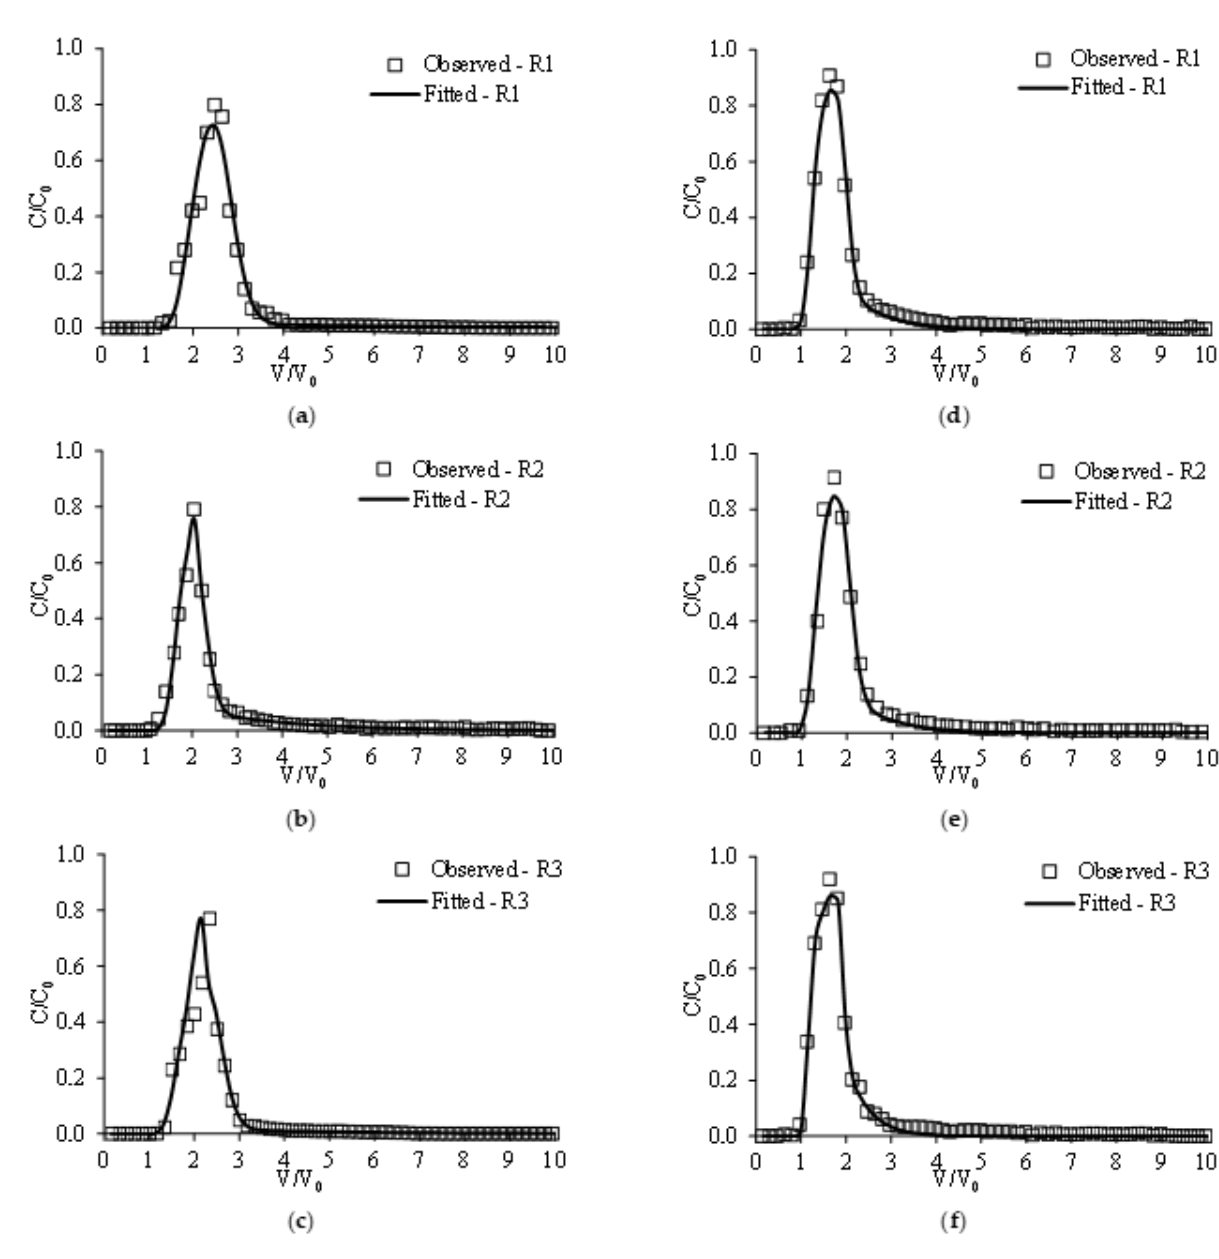
Figure 4. RB5 BTCs observed and fitted by CXTFIT for two-site model CM1 ( a – c ) and CM2 ( d – f ). Table 7. Estimated values of parameters, determination coefficient R 2 and MSE, DR, ME, and RMC statistical criteria for the two-site model for CM1 and CM2.